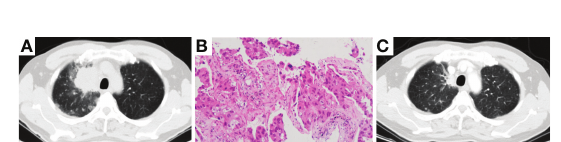
FIGURE 2 Chest CT scan of PD resistant to erlotinib (A) , photomicrograph of re-biopsy (H&E stain) showing lung adenocarcinoma (B) and chest CT scan of best response PR after the treatment of chemotherapy combined with PD-1 inhibitor (C) . CT, computed tomography; PD, progressive disease; PR, partial response; PD-1, programmed cell death 1.